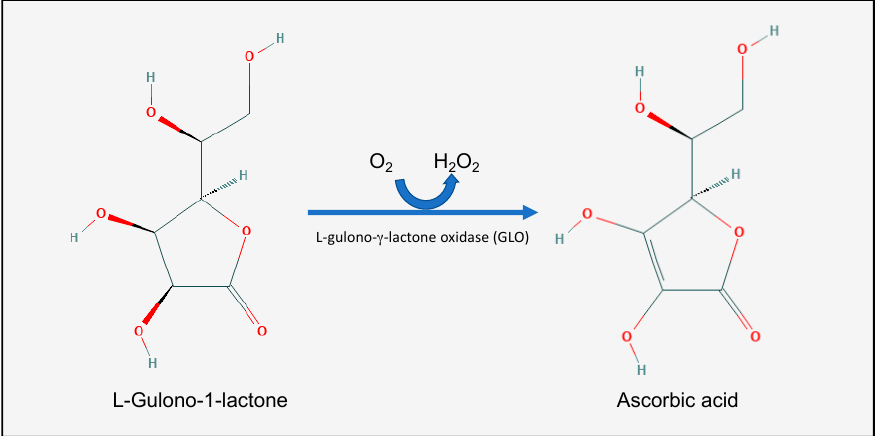
Figure 1. The last step in vitamin C (C 6 H 8 O 6 , or L -Ascorbic acid) biosynthesis. Humans have lost the ability to synthesize the GLO enzyme, and thus are dependent on exogenous vitamin C intake through their diet. Modified from: U.S. National Library of Medicine, PubChem.